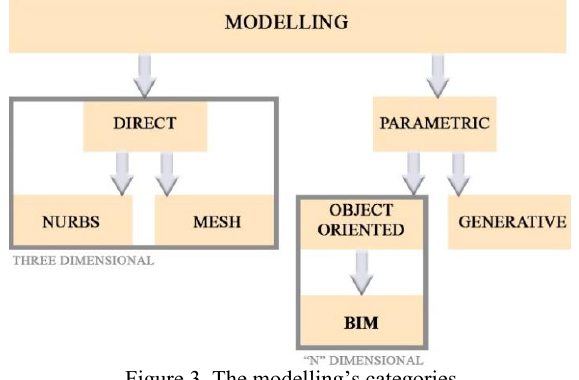
Figure 3. The modelling’s